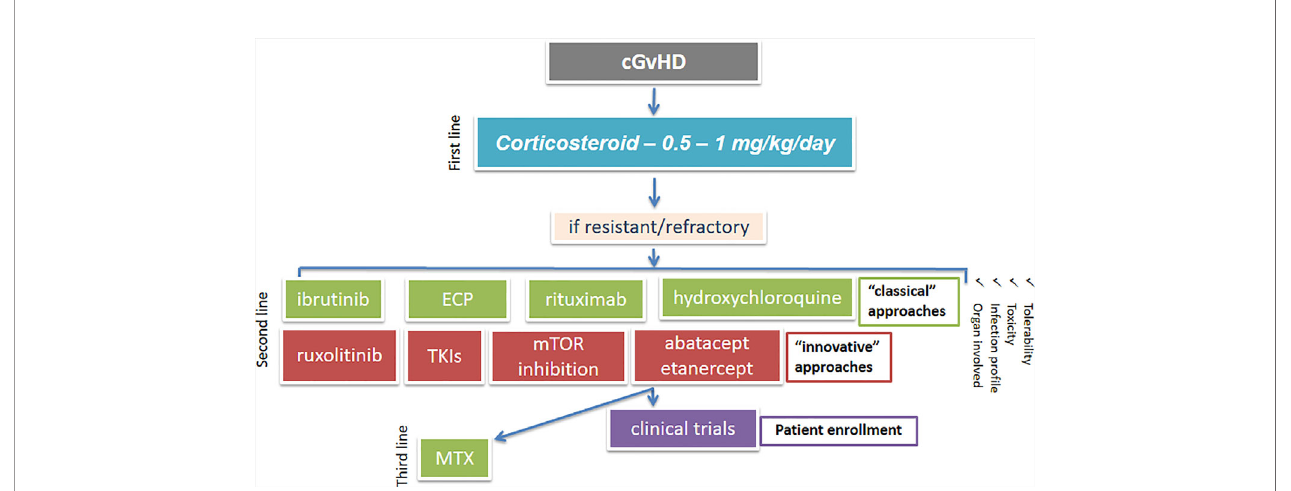
FIGURE 3 | An algorithm showing possible treatment options for cGvHD. cGvHD, chronic graft-versus-host disease; mTOR, mammalian target of rapamycin; ECP, extracorporeal photopheresis; TKI, tyrosine kinase inhibitor; MTX,